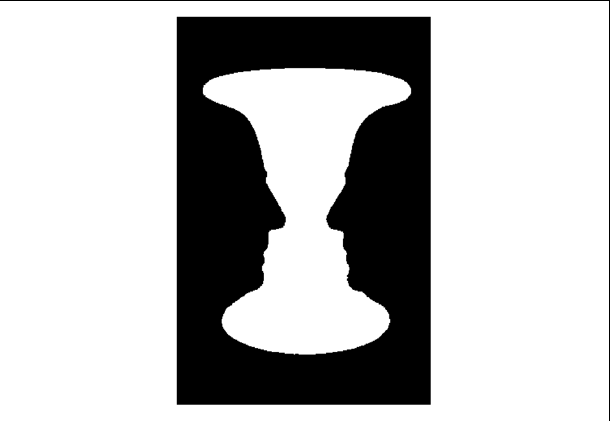
FIGURE 2 |A bistable stimulus according to Rubin